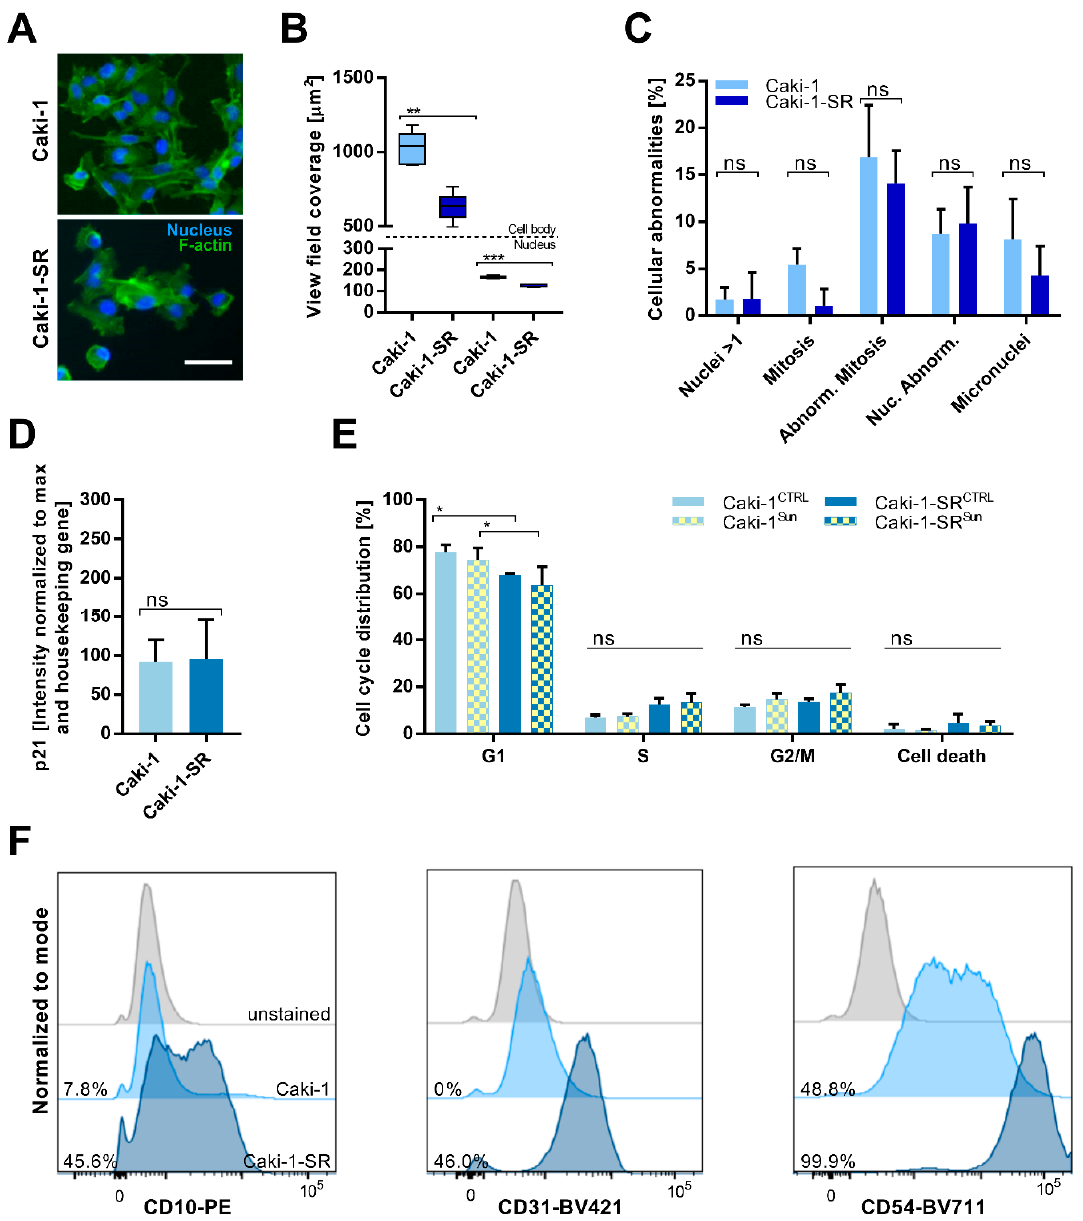
Figure 1. Identification of alterations between sunitinib-naïve Caki-1 and sunitinib-resistant Caki-1-SR cells. ( A ) Representative images of Caki-1 (top) and Caki-1-SR (bottom) cells fluorescently stained to visualize f-actin (green, GFP) and the nucleus (blue, Dapi). Scale bar = 20 µm. ( B ) Size of the cell body (above the dotted line) and the nuclei (below the dotted line) of Caki-1 and Caki-1-SR cells are expressed as the area covered in the view field. Error bars represent the SD. Statistical significance was calculated based on n = 3 independent experiments using Student’s t -test. ** p < 0.01, *** p < 0.001. ( C ) Bar graphs representing the appearance of cellular abnormalities analyzed in Caki-1 and Caki-1-SR cells. Error bars represent the SD. ( D ) Measurement of the expression of p21, a cyclin-dependent kinase inhibitor, in Caki-1 and Caki-1-SR cells. The protein expression was analyzed through Western blot experiments and is given as % intensity normalized to the maximal intensity measured as well as the housekeeping gene. ( E ) Cell cycle analysis demonstrating the number of cell given as % per cell cycle phase (G1, S, G2/M and cell death). Error bars represent the SD. Statistical significance was calculated based on n = 2–3 independent experiments using Student’s t -test and two-way ANOVA with unequal variances; * p < 0.05. ( F ) Histograms showing the differential expression of the surface proteins CD10 (left graph), CD31 (middle graph) and CD54 (right graph). The expression was detected using flow cytometry experimentation comparing the unstained control (grey), Caki-1 cells (light blue) and the Caki-1-SR cells (dark blue).